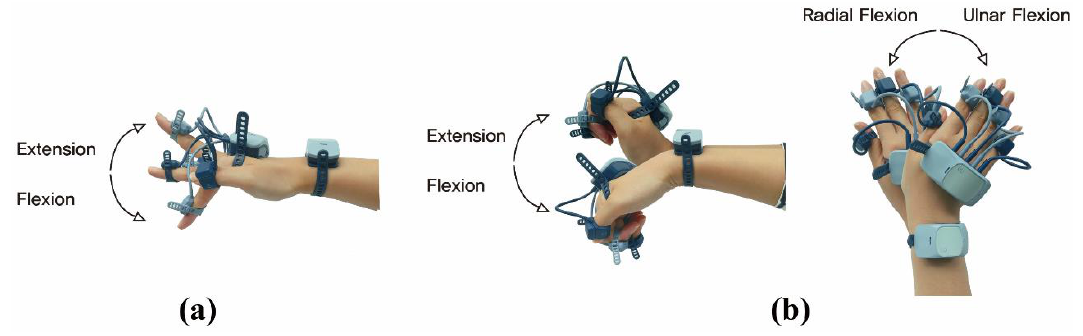
Figure 1. Definition of range of motion of the hand and wrist: ( a ) finger extension and flexion and ( b ) wrist flexion/extension and wrist radial/ulnar flexion.